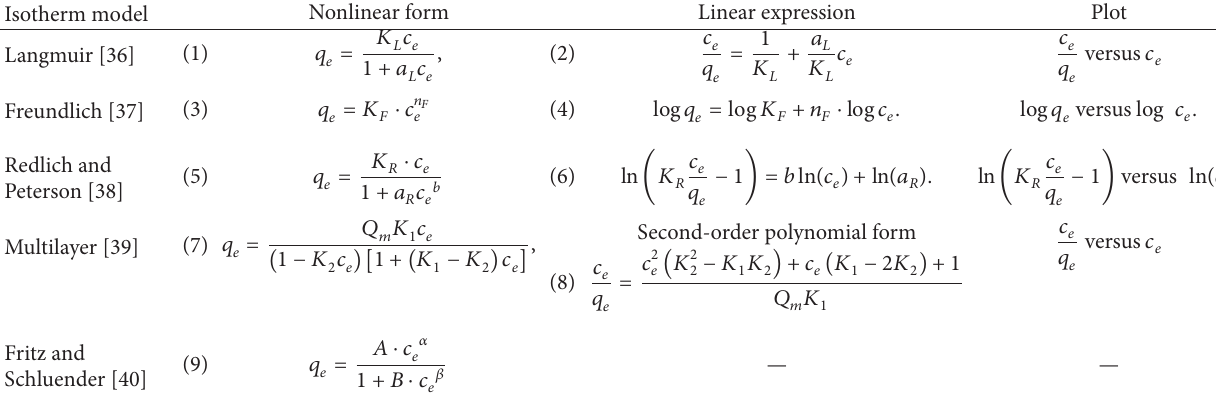
T 1: Mathematical equations of the applied single component isotherm models. Isotherm model